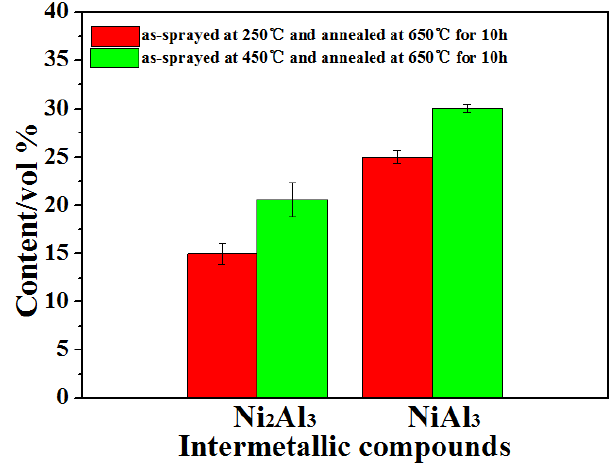
Figure 18. The contents of NiAl 3 and Ni 2 Al 3 intermetallic compounds in the annealed Ni/Al-TiB 2 composite coatings.